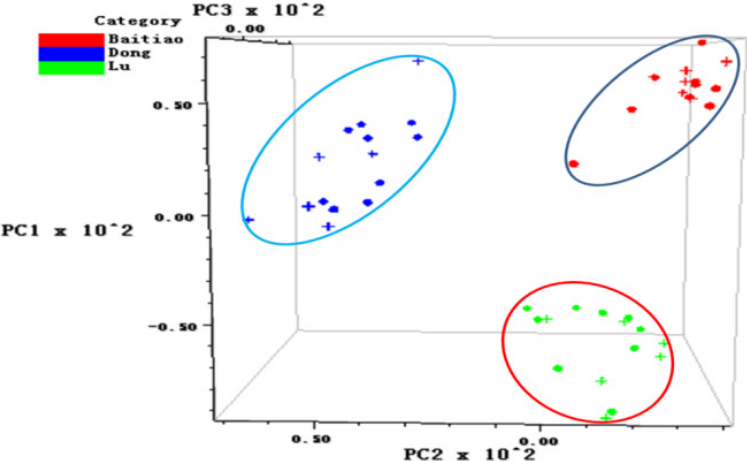
Fig. 6. Plots of PCA scores (PC1 vs PC2 vs PC3) of three geographical classes samples. Red represents the Baitiao samples (Gansu); blue represents the Ludang samples (Shanxi); and green represents the Dongdang samples (Northeast).